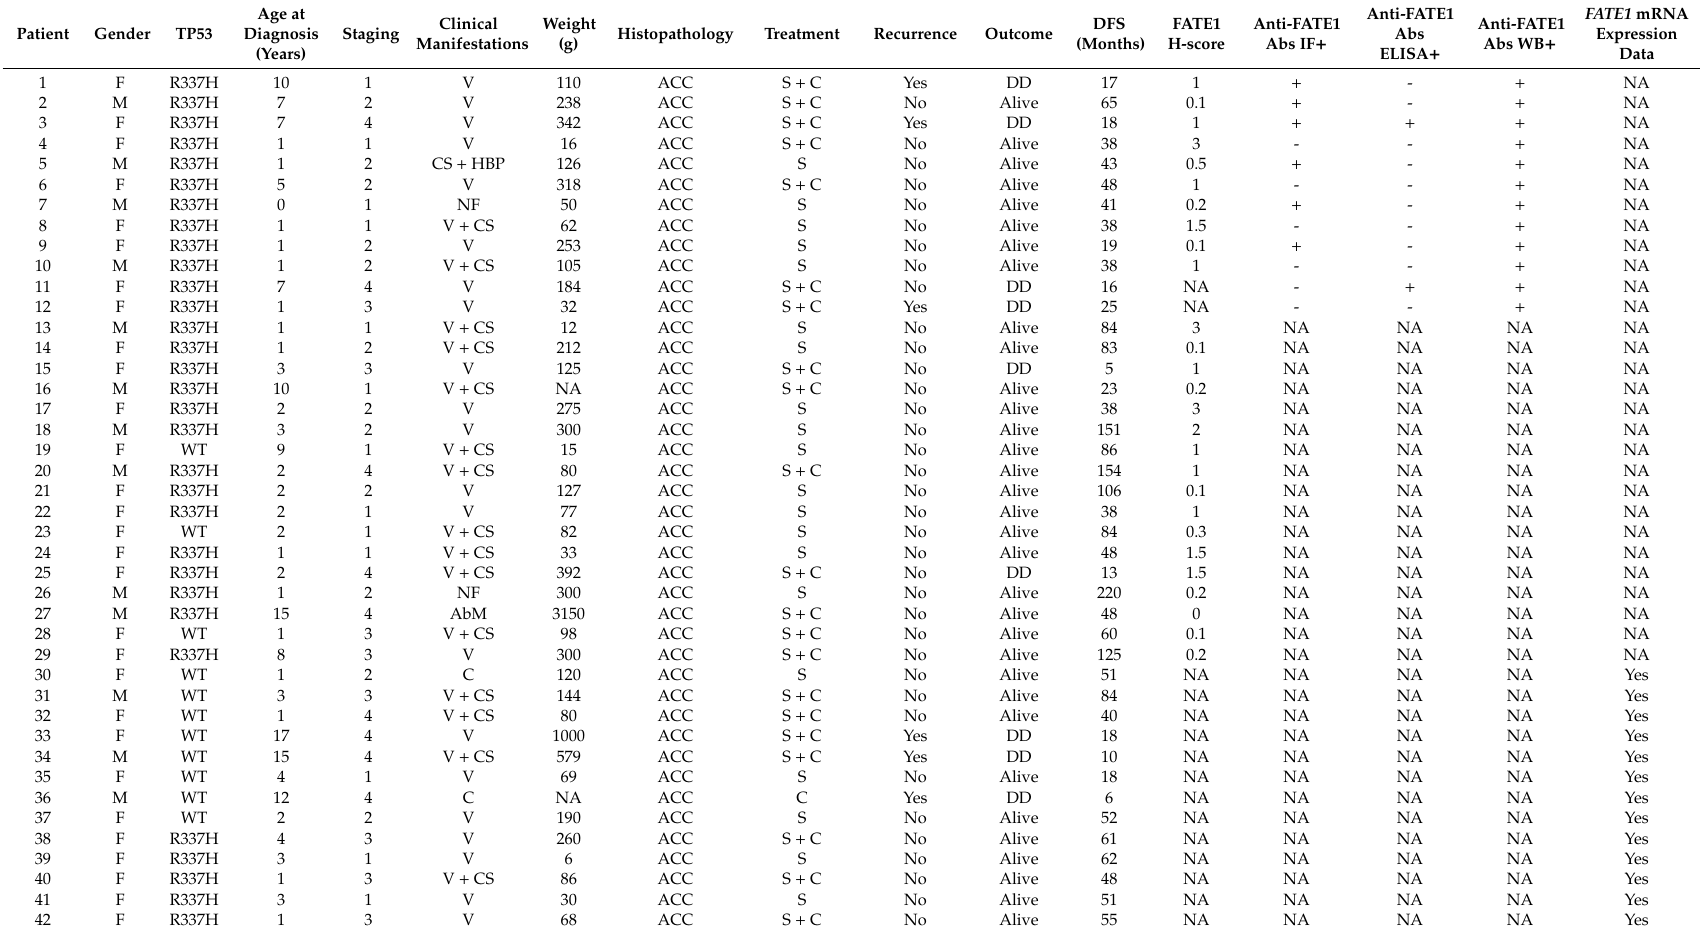
Table 1. Clinical, histopathological, serological and gene expression features of children with ACC in this